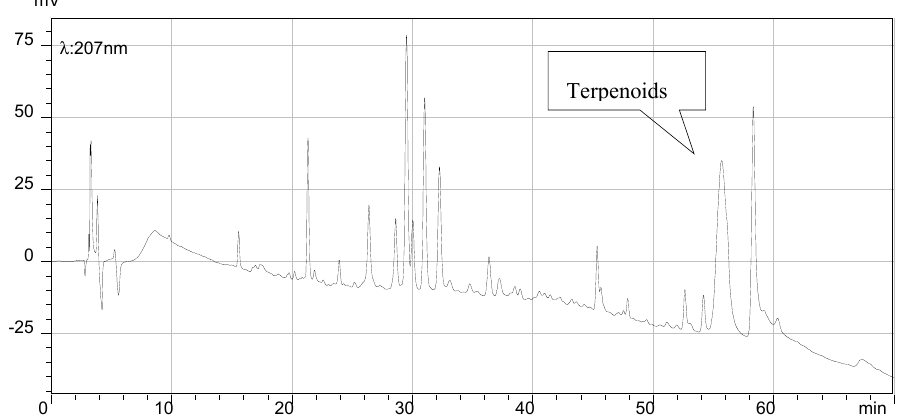
Figure 7. HPLC chromatogram of crude flavonoid extracts ( λ = 207 nm). The broad peak with retention time of 55.47 min was terpenoids.